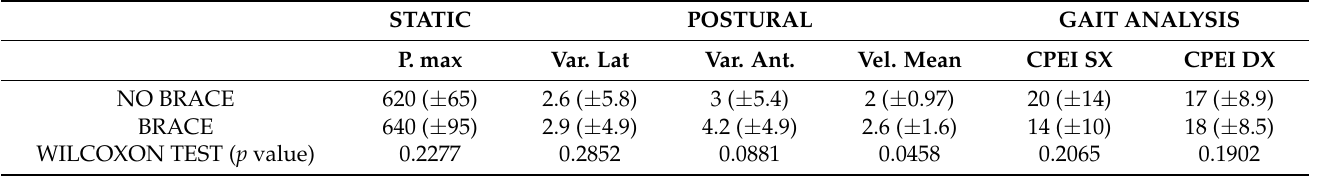
Table 1. Means and standard deviations of measurements recorded in static, postural, and dynamic assessments with and without the brace as well as the relative p value. Point of maximum pressure (P. max); Var Lat. (lateral variation); Var. Ant (anterior variation); Vel. Mean (mean velocity); CPEI (center of the pressure excursion index). STATIC POSTURAL GAIT ANALYSIS P. max Var. Lat Var.